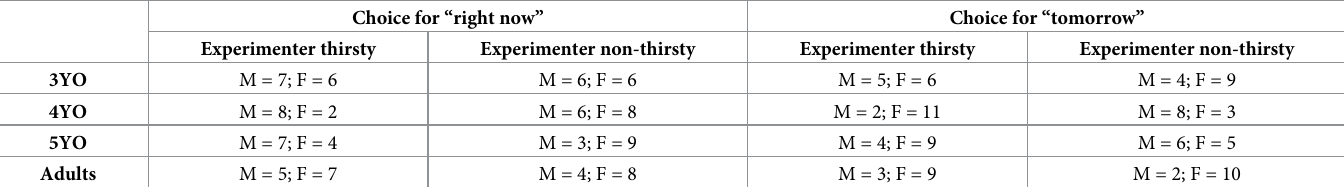
Table 1. Number of participants per experimental condition as a function of age and gender. Choice for “right